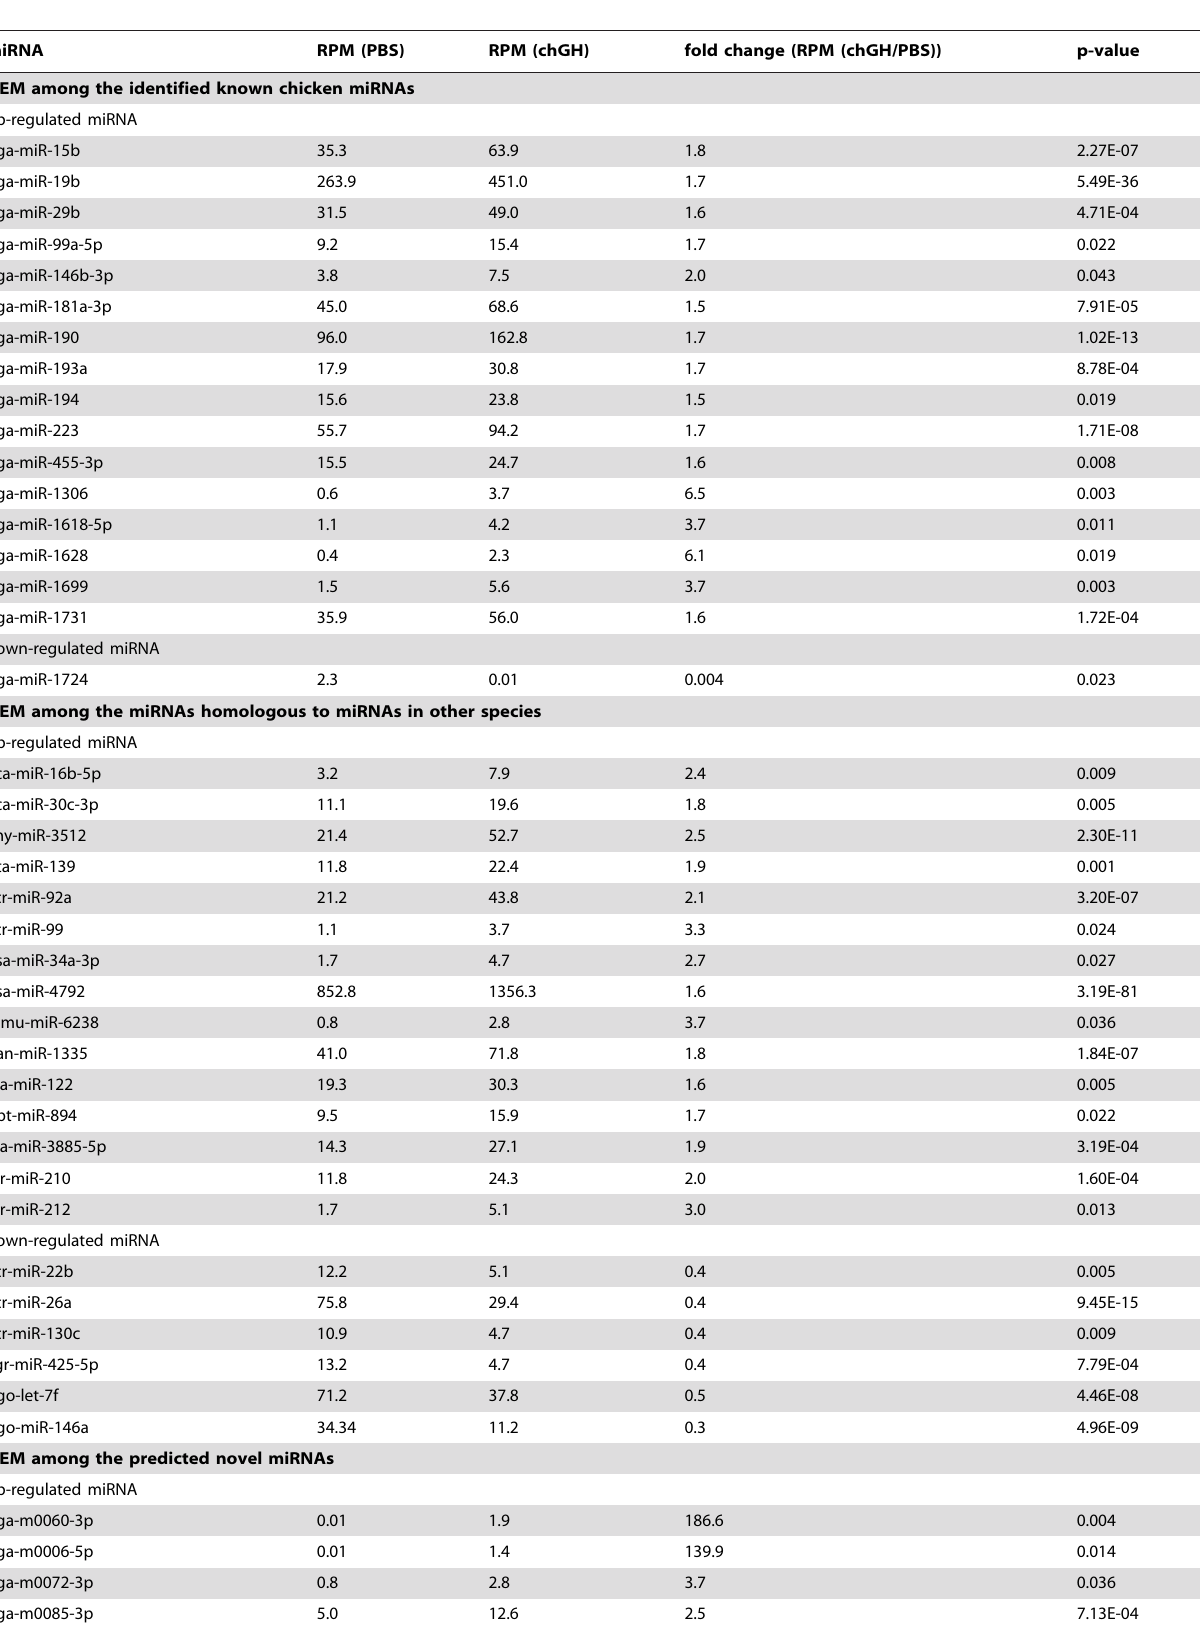
Table 8. chGH-regulated miRNAs among the identified known and predicted chicken miRNAs.